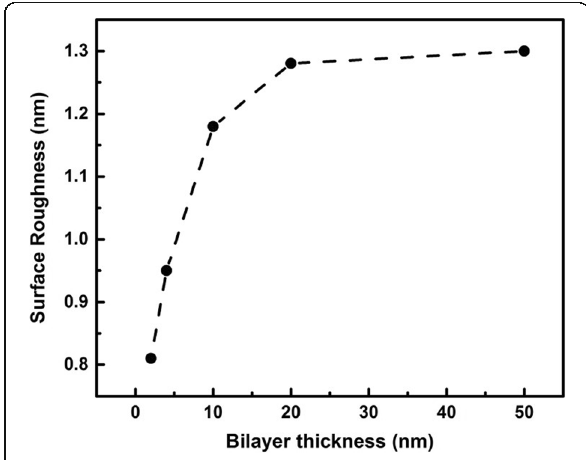
Fig. 5 Optical model of samples grown on SiO 2 /Si substrate for SE